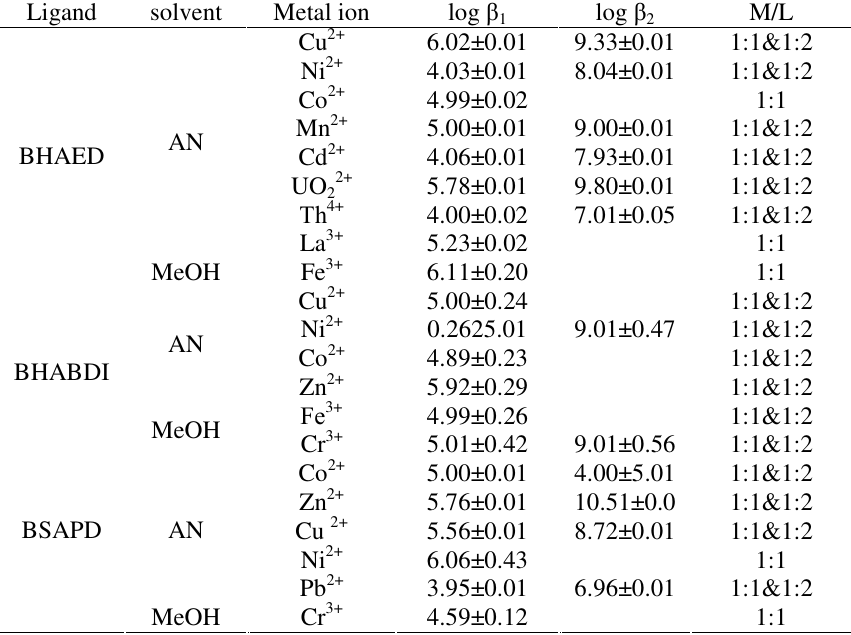
Table 2. The overall stability constants of complexation between some metal ions with